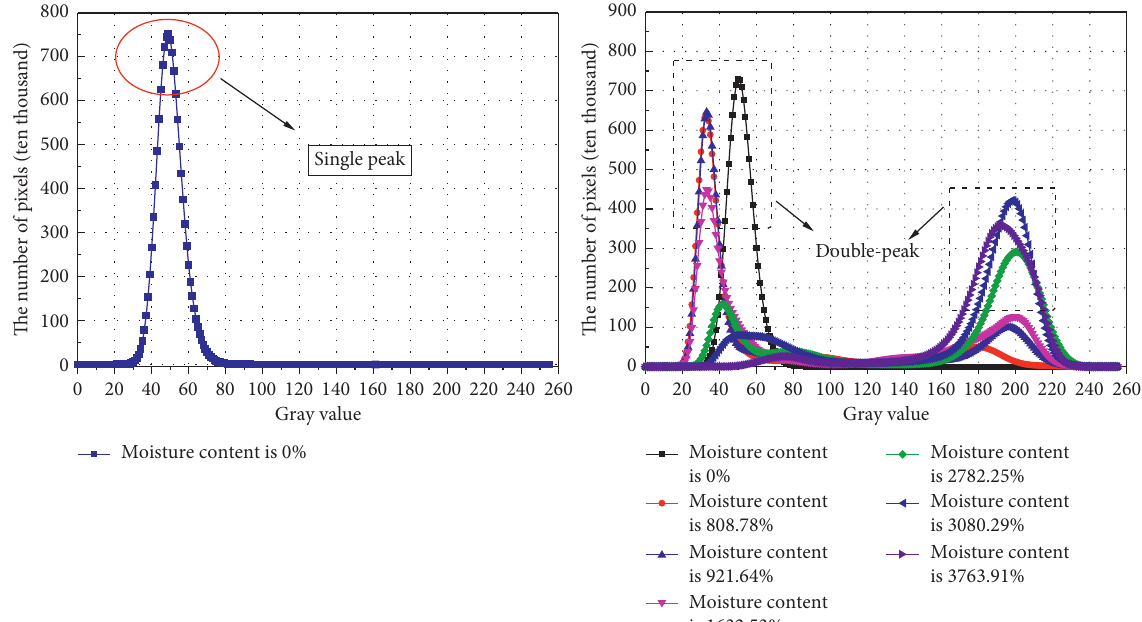
Figure 10: Gray histogram of the phenolic insulation panels with different moisture